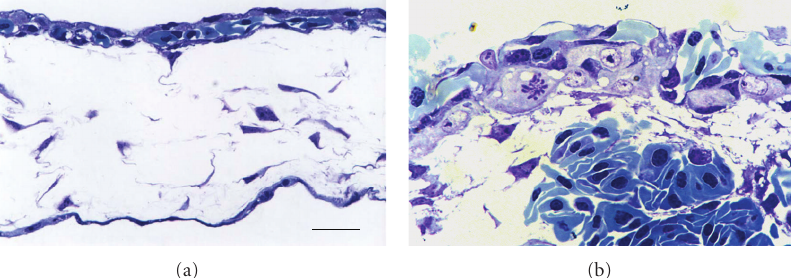
Figure 2: Two successive aspects of di ff erentiating capillary plexus, at day 8 ((a) original magnification: 40x; scale bar: 10 μ m) and day 11 ((b) original magnification: 100x; scale bar: 5 μ m) of incubation. The chorionic epithelium in (b) shows early cellular proliferation. Toluidine blue staining. M. G. Gabrielli , unpublished